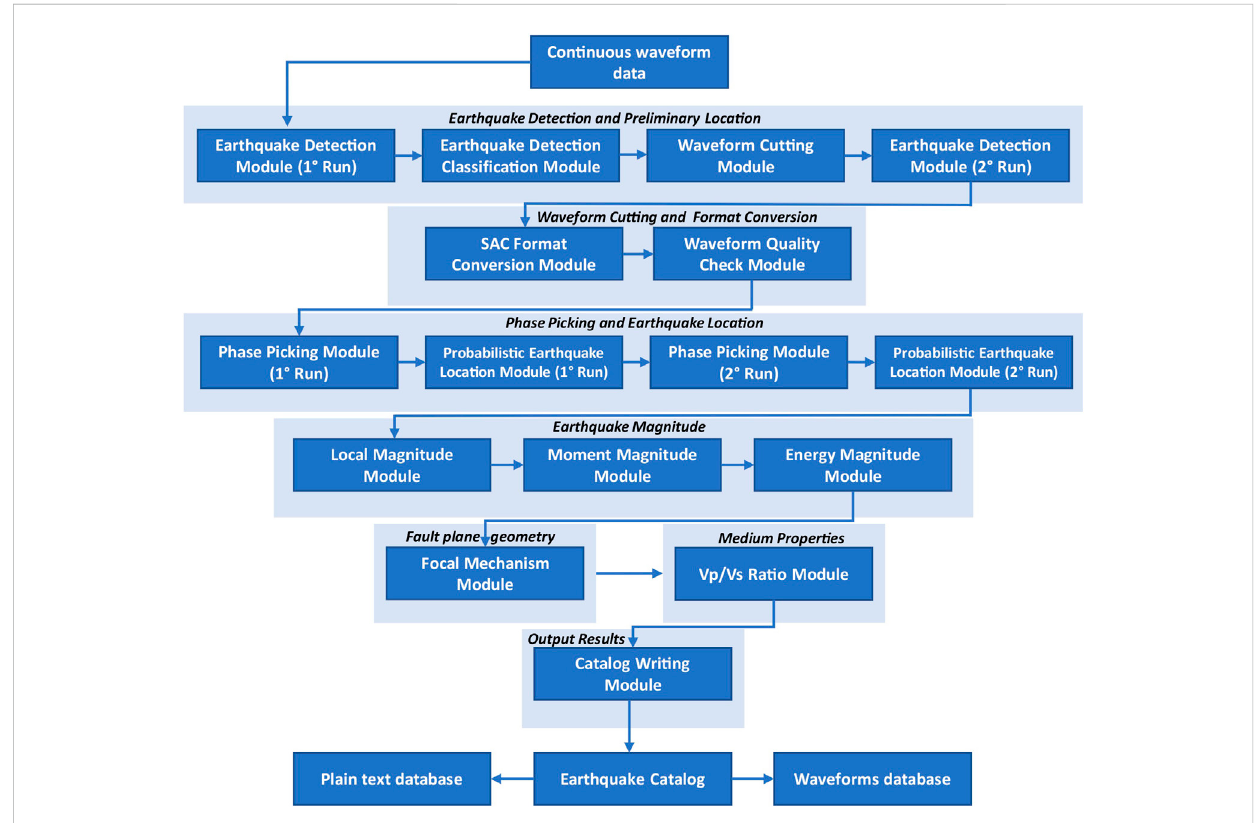
FIGURE 1 Work fl ow of the processing scheme implemented in the computational earthquake monitoring platform. Computational modules inside the program are